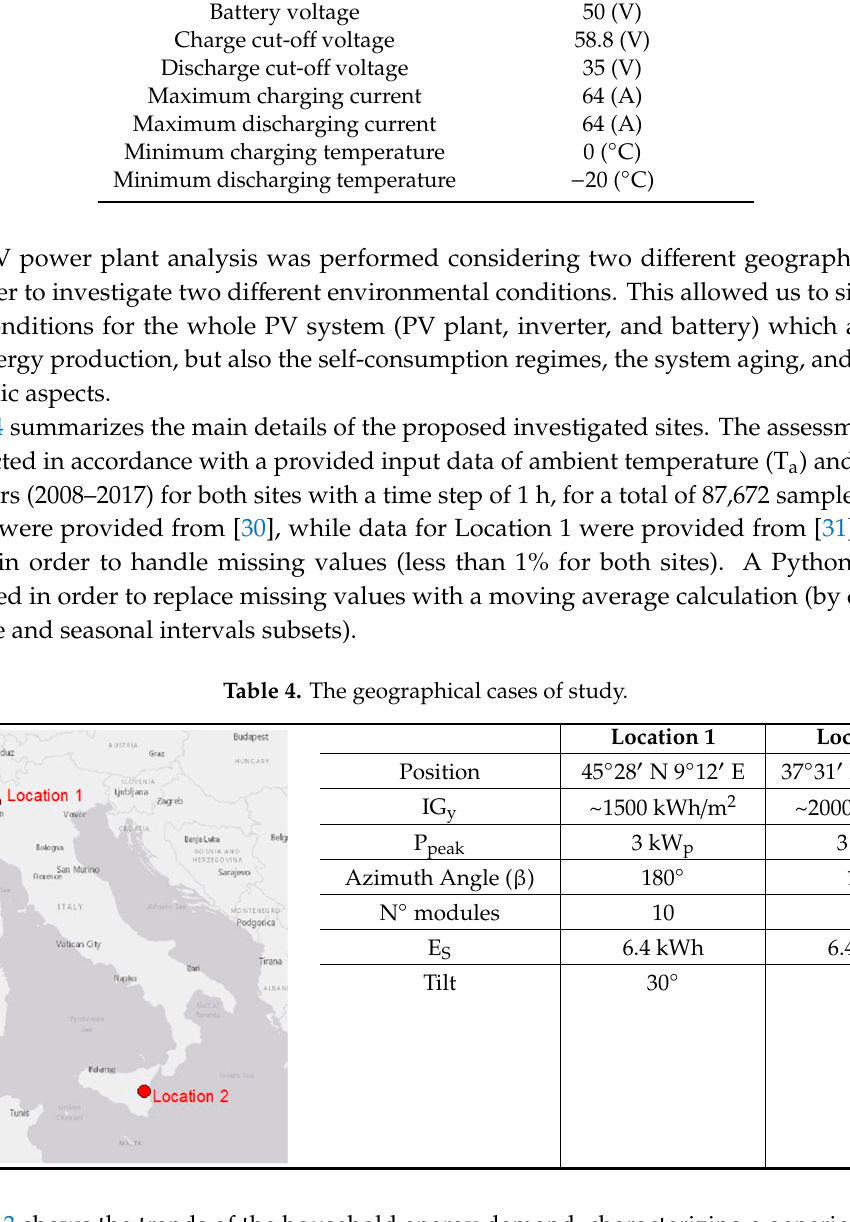
Table 3. Main characteristics of the storage system.